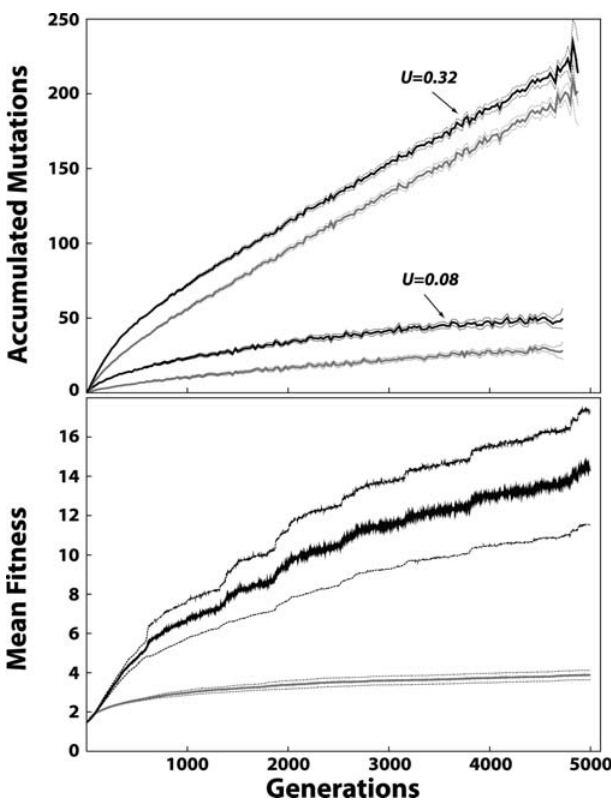
Figure 4. Mutation Accumulation and Mean Fitness of Evolving Populations The top pane shows the accumulation of beneficial and deleterious mutations in the lineage leading to the MRCA, while the bottom pane shows the mean fitness of the populations over time. In both panes, the thicker lines represent the mean value, and the thin, dotted lines represent bounds for 95% confidence intervals. In the top pane, the dark lines represent beneficial mutations and the light lines represent deleterious mutations (see text for definition). The jaggedness in the lines is the result of averaging over all simulations, which frequently differ in the length of their MRCA lineages. Within any single run the number of mutations monotonically increases. In the lower pane, the dark lines correspond to U ¼ 0.32 and the light lines correspond to U ¼